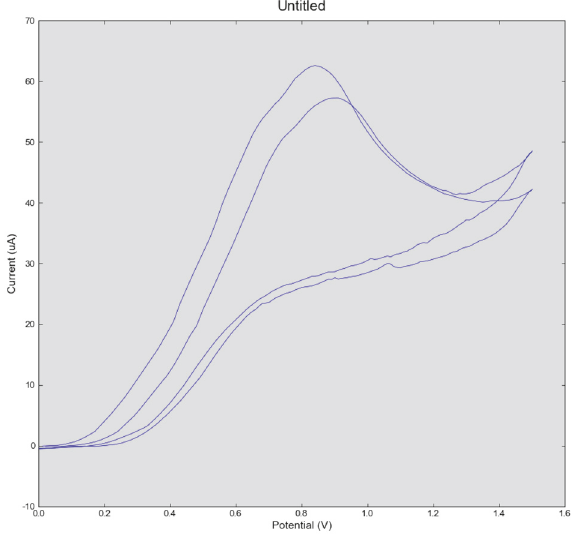
Figure 6: Cyclic voltammetry study of sensor electrode for electro- chemical analysis.